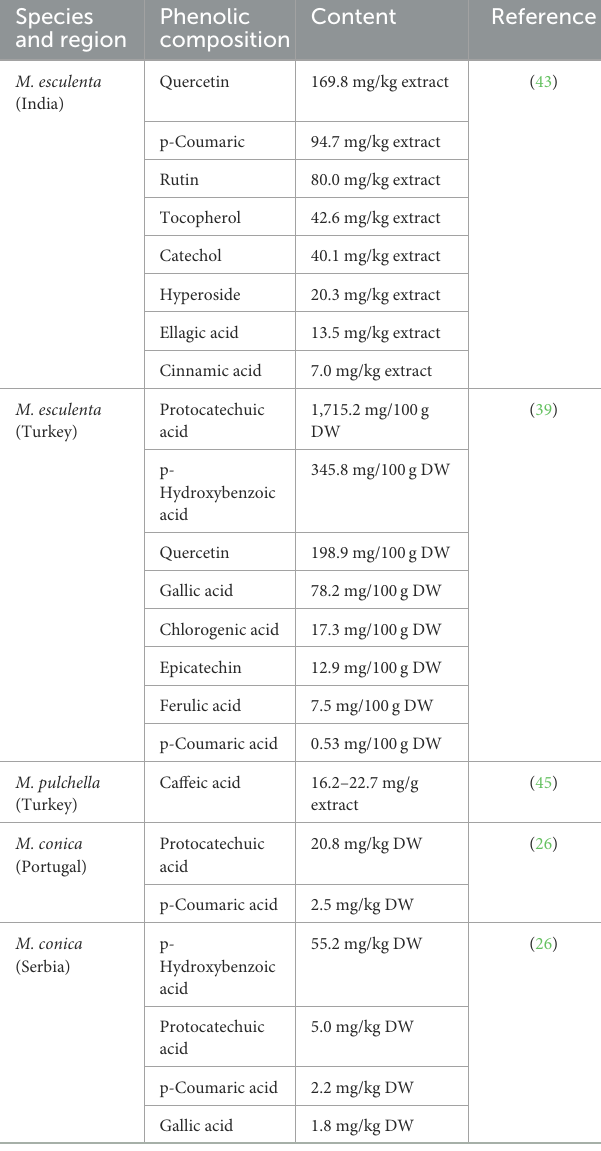
TABLE 4 Composition of phenolics in different morel